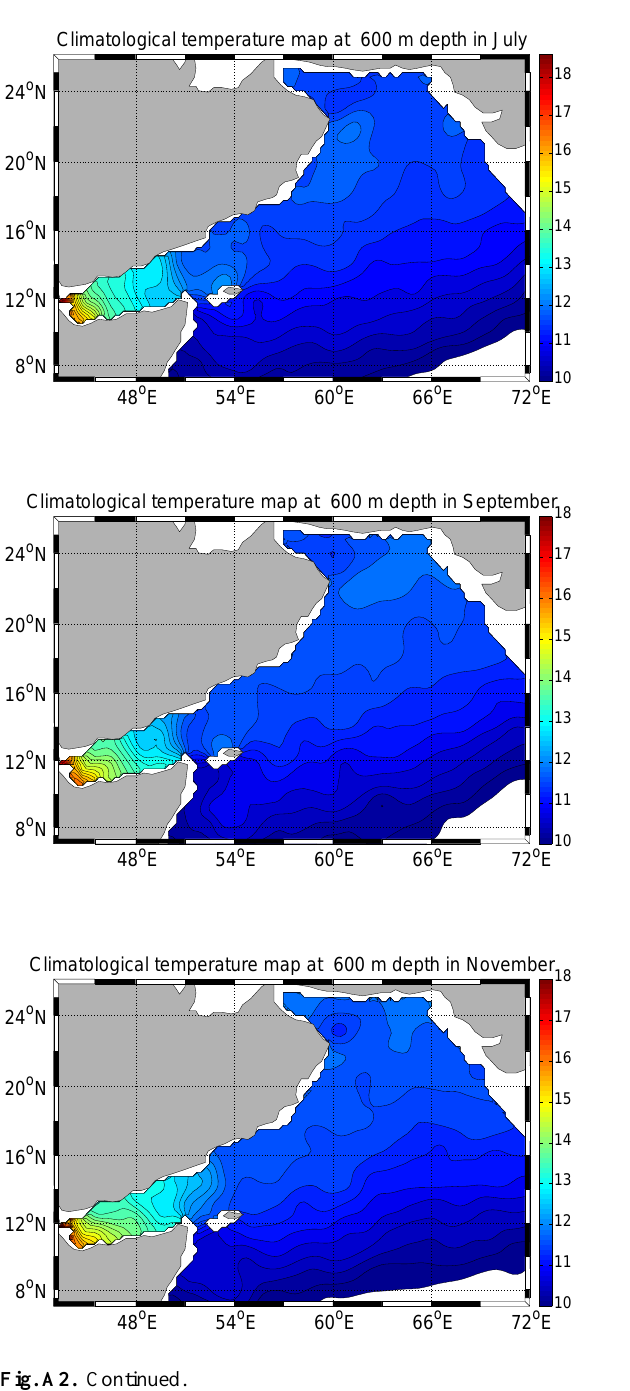
Fig. A2. Figure 27: (Continued from previous page) Horizontal maps of temperature (in o C , left) and salinity (right) at 600 m depth for January, March, May, July, September, November (from top to bottom), from the climatology